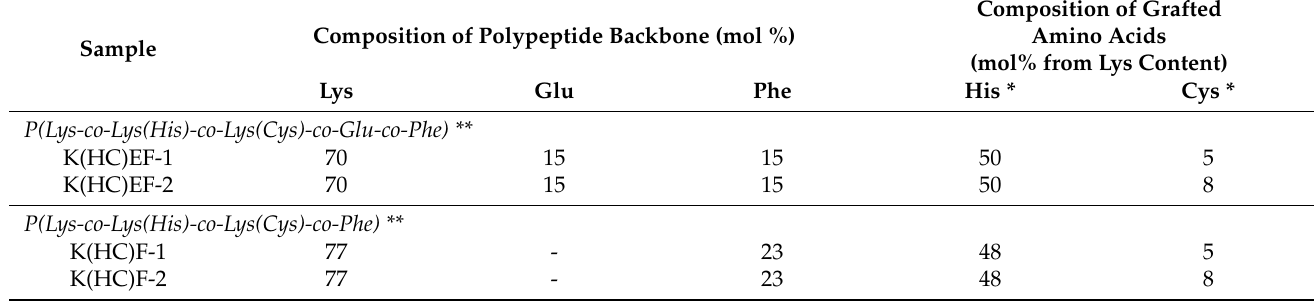
Table 1. Compositions of the synthesized stimuli-responsive polypeptides.